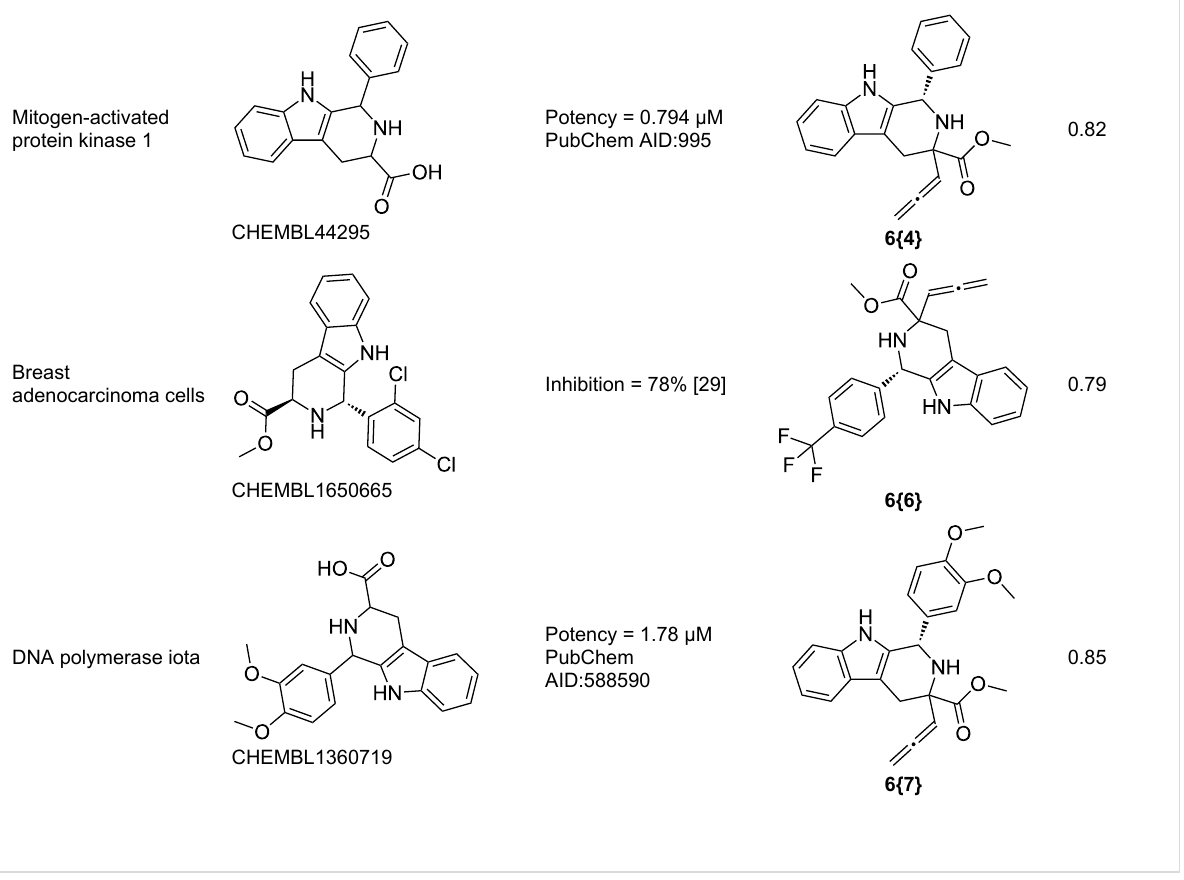
Mitogen-activated protein kinase